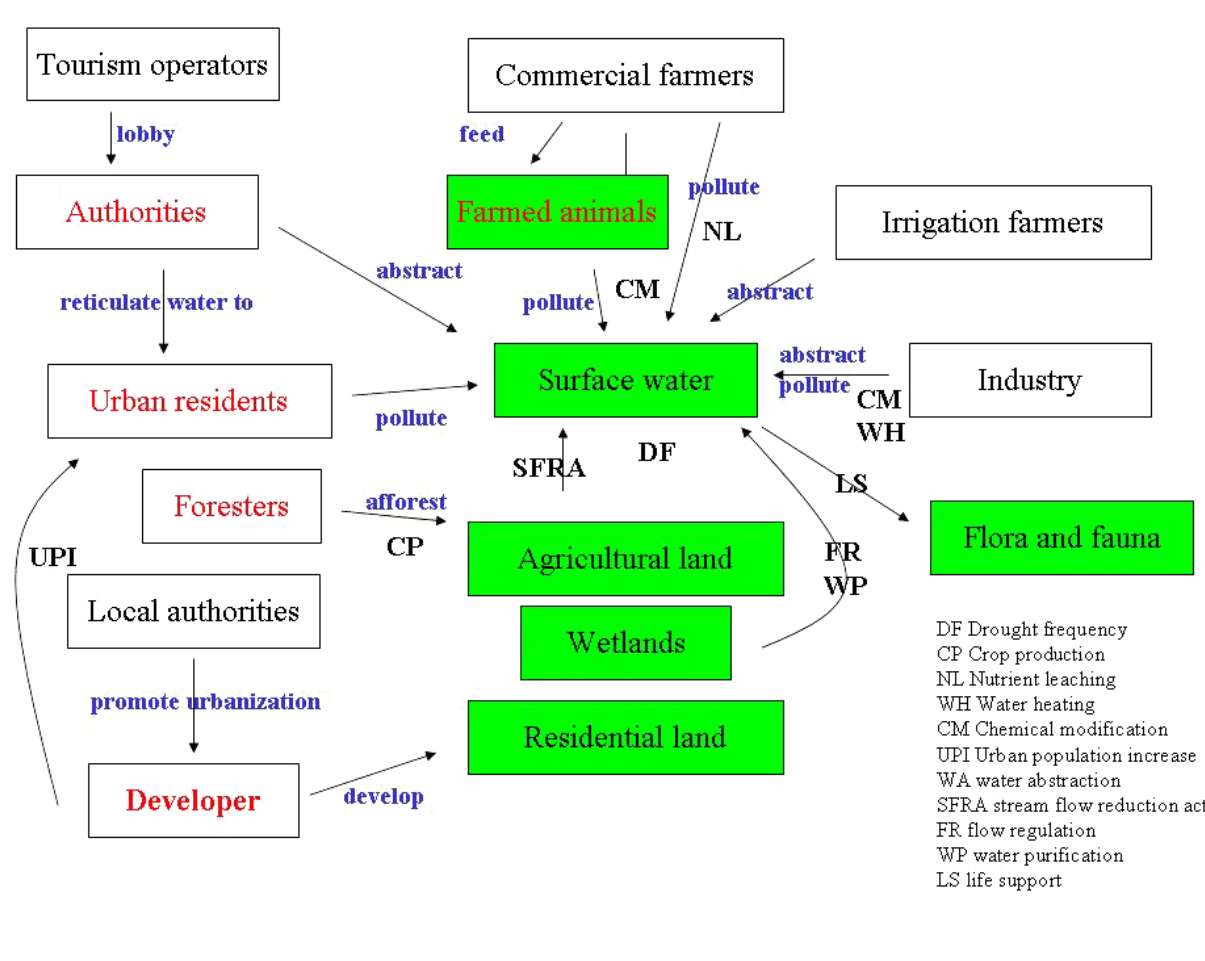
Fig. 5 . ARDI stage 4 at Crocodile River: “How does each stakeholder use the resources and modify the processes?“ White boxes indicate stakeholders, green boxes indicate resources, boldfaced letter codes indicate processes, and blue text indicates actions. Words or concepts written in red were added during the later steps of the